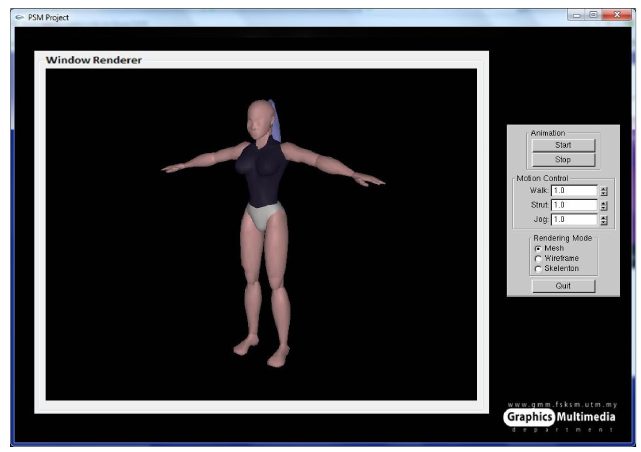
Fig. 4. Prototype of the animation